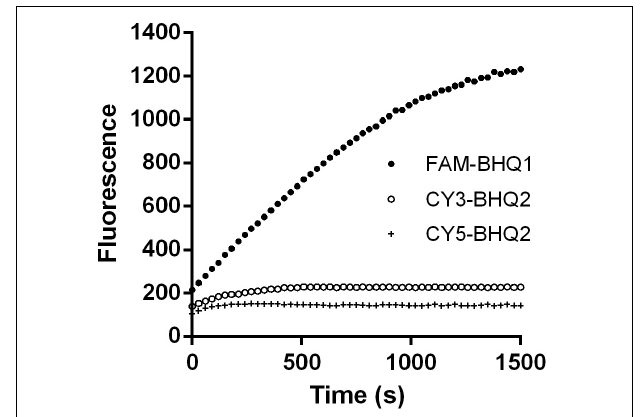
FIGURE 2 | Degradation time course of a 24-bp EGFP dsRNA substrate labeled with different fluorophores and quenchers. Three different combinations of fluorophore and quencher types were considered: 5-FAM fluorescent donor and 3-BHQ1 quencher-labeled strands (5-FAM/3-BHQ1), 5-Cy3 fluorescent donor and 3-BHQ2 quencher-labeled strands (5-Cy3/3-BHQ2), and 5-Cy5 fluorescent donor and 3-BHQ2 quencher-labeled strands (5-Cy5/3-BHQ2). The gut fluid from S. litura was 20-fold diluted (1 µ L fluid + 19 µ L nuclease-free water) and incubated with 1 µ L of a 24-bp EGFP dsRNA labeled with different fluorophore/quencher combination (final concentration 0.5 µ M) at 37 ◦ C. The florescence signal resulted from degradation of the dsRNA was monitored at 30 s intervals from 0 to 1500